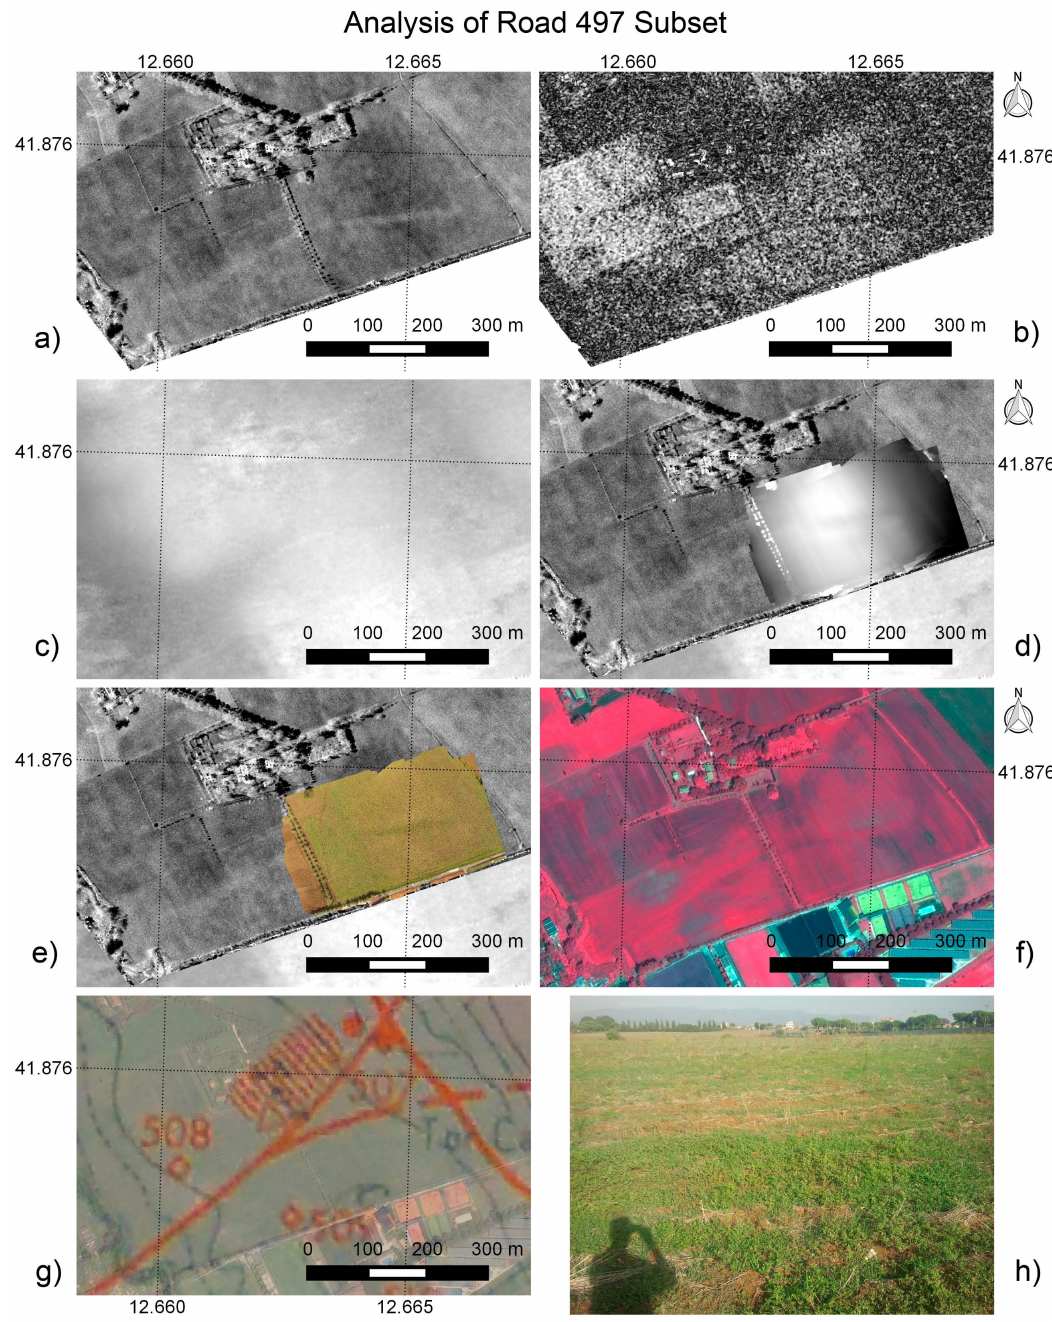
Figure 36. Subsets of Road 497, as shown in yellow rectangle in Figures 28–32: ( a ) CSK Spotlight image of filtered σ 0 backscatter, acquired on 25 July 2010; ( b ) CSK Spotlight coherence image with 16 day temporal baseline from image pairs acquired on 9 and 25 July 2010; ( c ) SBAS DEM produced from CSK Spotlight time series; ( d ) DEM derived from UAV photogrammetric imagery acquired on 6 October 2015, overlain on imagery in part ( a ); ( e ) Orthophoto acquired by UAV on 6 October 2015, overlain on imagery in part ( a ); ( f ) Pleiades image acquired on 20 April 2014, pan-sharpened to 0.5 m spatial resolution. NIR, R and G displayed as R, G and B respectively; ( g ) Archaeological chart of Quilici, 1974 [46] overlain on true colour Pleiades image acquired on 20 April 2014; ( h ) Photo 5. Acquired on 19 September 2015 at 17:03 CET. The location and direction from which the photo was taken is shown in Figures 28–32. COSMO SkyMed data provided by the Italian Space Agency. Pleiades data provided by the European Space